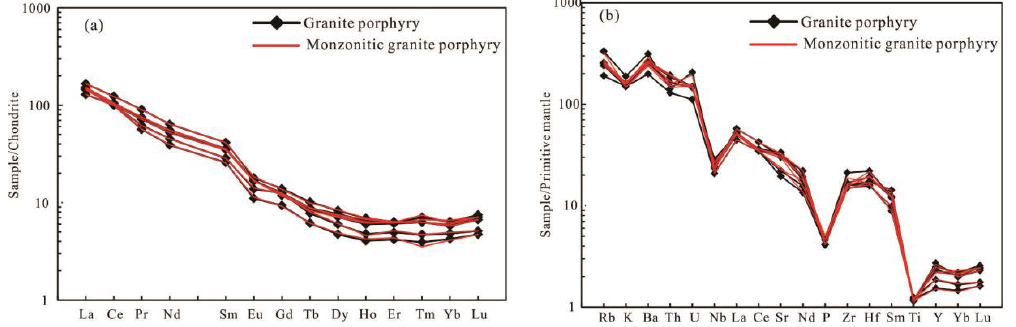
Figure 8. Chondrite-normalized REE patterns diagram ( a ) and primitive mantle normalized trace element spider diagram ( b ) for the Leimengou granite porphyry and monzonitic granite porphyry (normalization values after Sun et al., 1989 [24]).